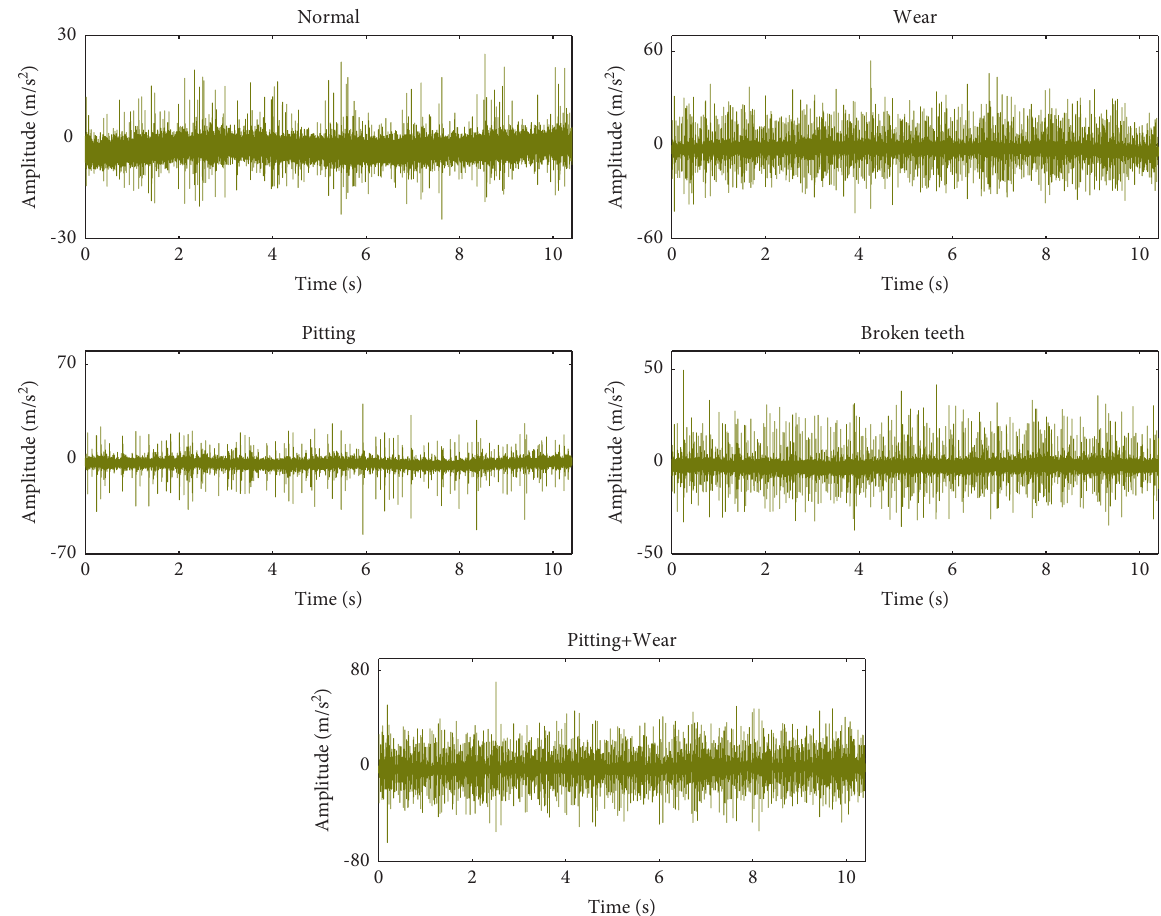
Figure 12: Time-domain waveforms corresponding to different states.